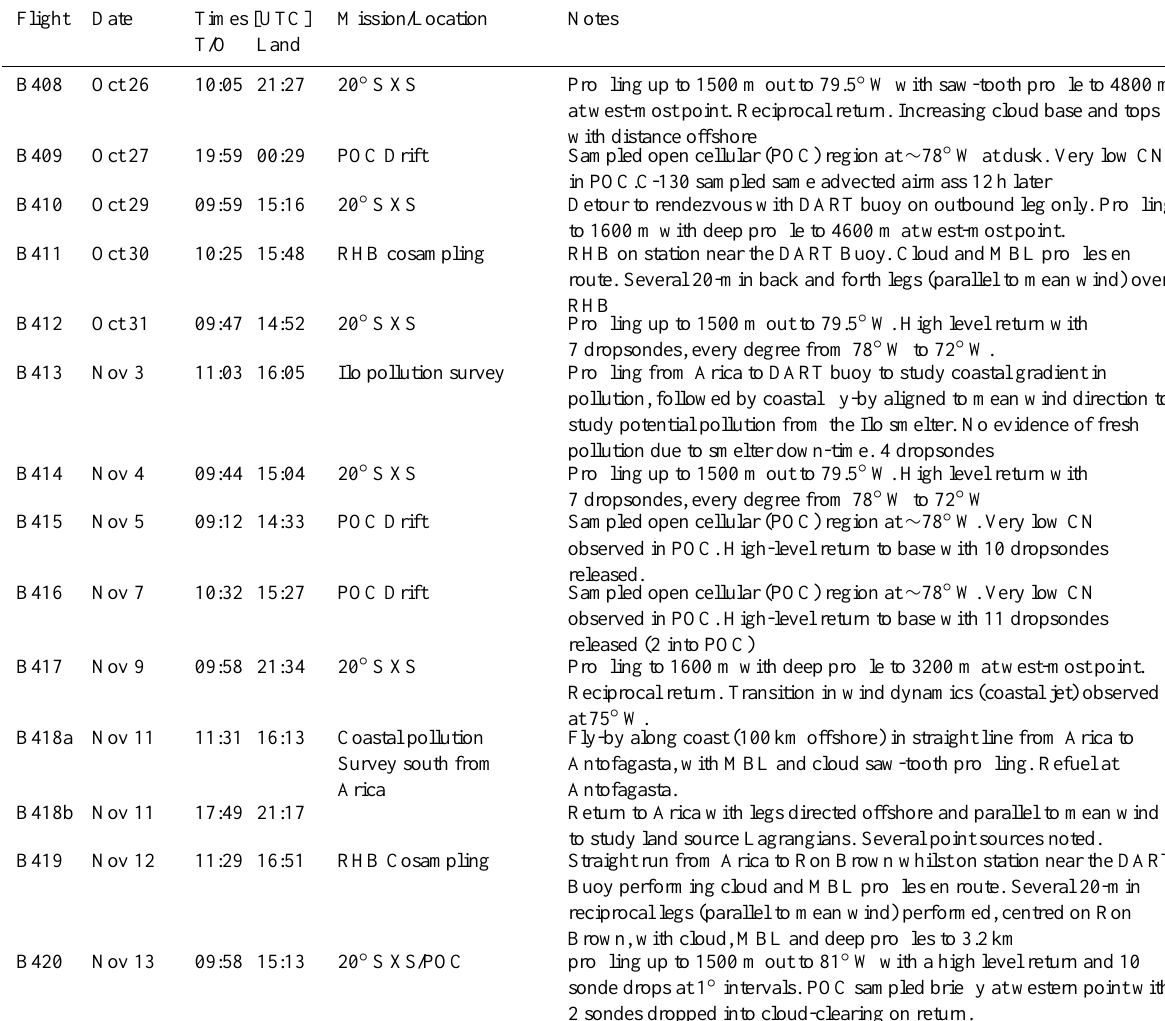
Table 7. Details of BAe-146 aircraft missions conducted in the VOCALS Regional